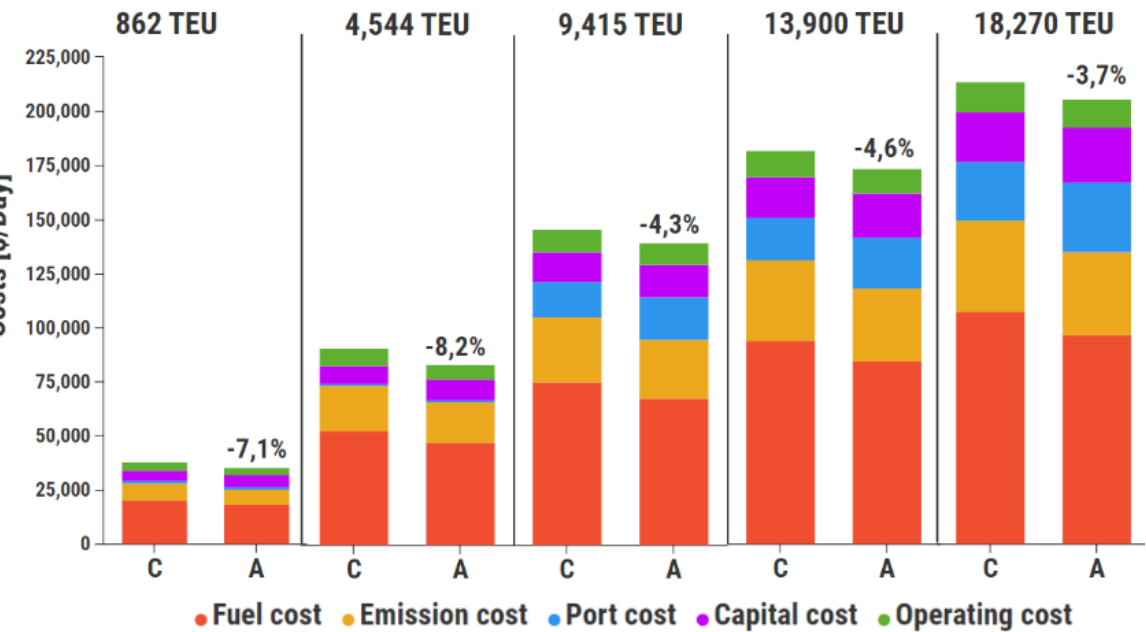
Figure 9. Daily costs of conventional and autonomous vessels.